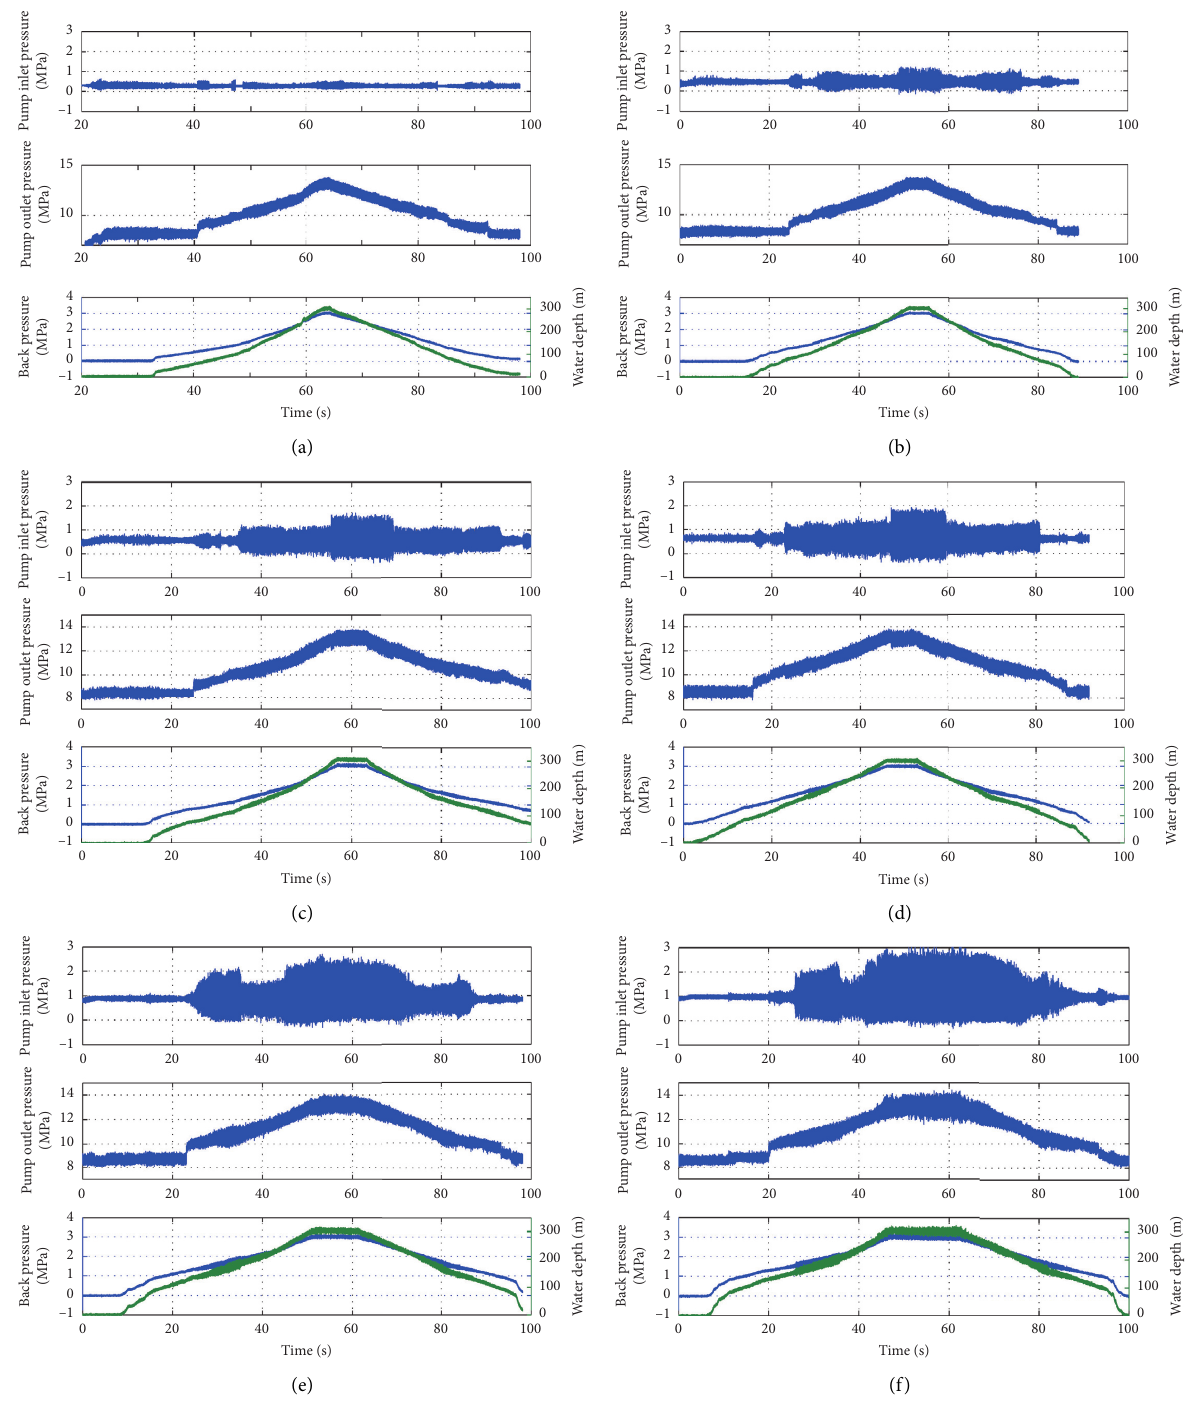
Figure 5: Experimental measurements for the case with inlet pressure of 0.4MPa (a), 0.5 MPa (b), 0.6MPa (c), 0.7 MPa (d), 0.9MPa (e), and 1.0 MPa (f),